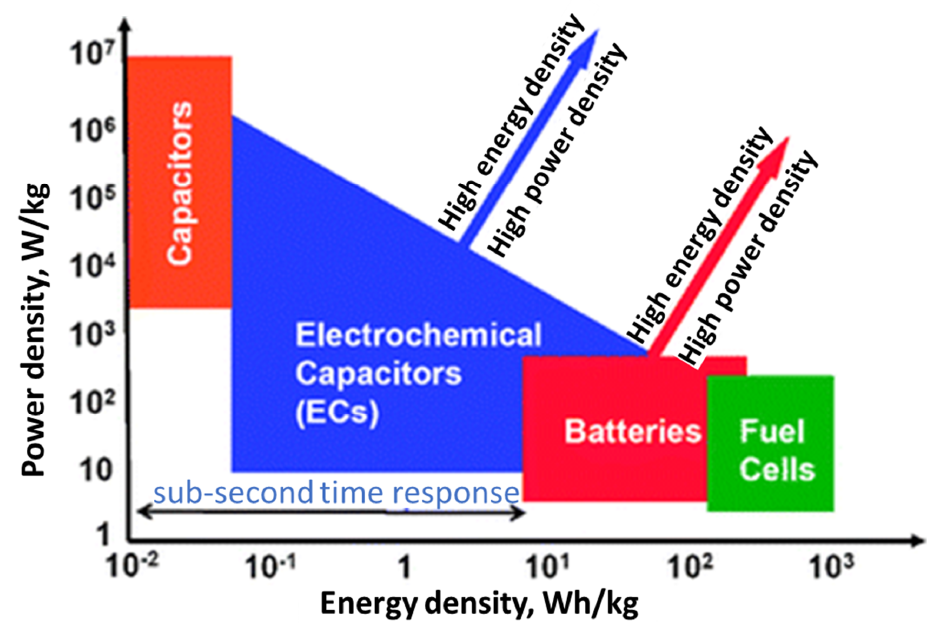
Figure 3. Ragone plot representing the distribution of ED and PD of electrochemical energy storage devices. Reproduced with permission from [31].